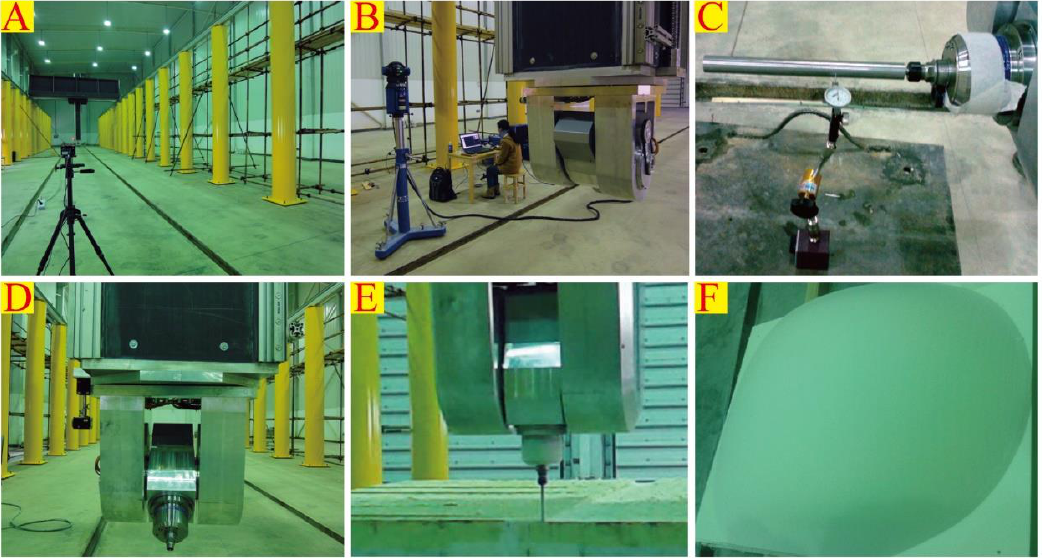
Figure 7. Actual test scenes: ( A ) inspection of a translational axis using a laser interferometer; ( B ) inspection of a rotational axis using a laser tracker; ( C ) milling head inspection; ( D ) dynamic drive performance inspection; ( E ) processing test; ( F ) a processed sample.